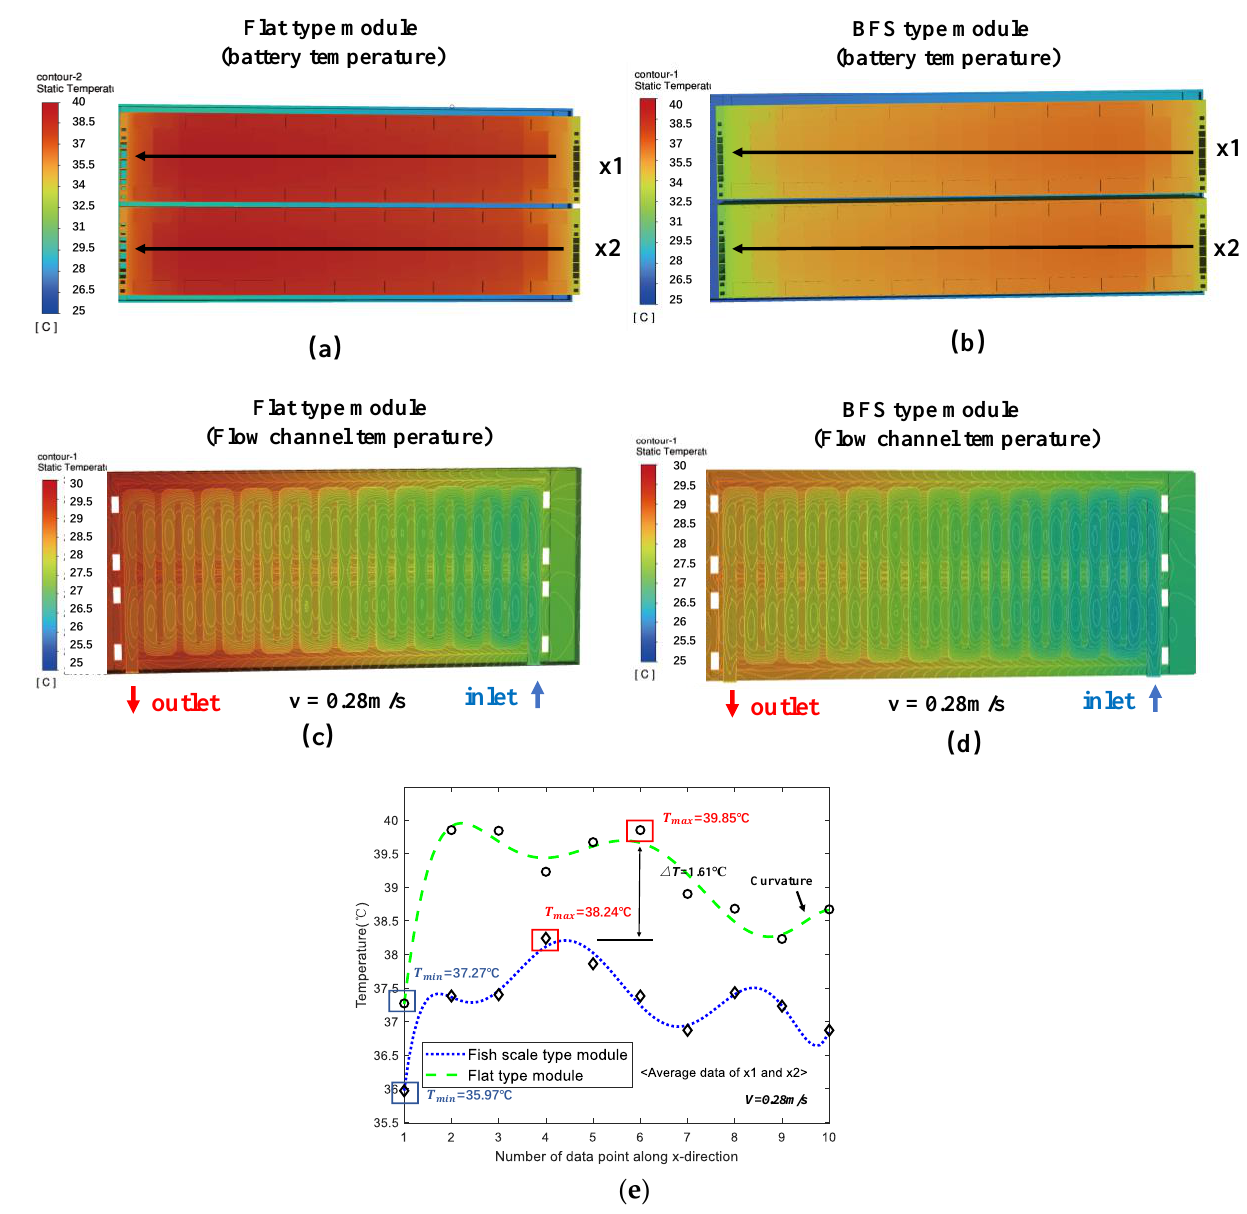
Figure 6 . ( a ) Thermal cloud of cell pack at 𝑇 𝑚𝑎𝑥 of flat type channel ( b ) Thermal cloud of cell pack Figure 6. ( a ) Thermal cloud of cell pack at T max of flat type channel ( b ) Thermal cloud of cell pack at 𝑇 𝑚𝑎𝑥 of BFS type channel ( c ) Thermal cloud of liquid cooling plate at 𝑇 𝑚𝑎𝑥 of flat type channel at T max of BFS type channel ( c ) Thermal cloud of liquid cooling plate at T max of flat type channel ( d ) Thermal cloud of liquid cooling plate at 𝑇 𝑚𝑎𝑥 of BFS type channel ( e ) Comparison of average ( d ) Thermal cloud of liquid cooling plate at T max of BFS type channel ( e ) Comparison of average values of temperature along x1 and x2 for both structures. values of temperature along x1 and x2 for both